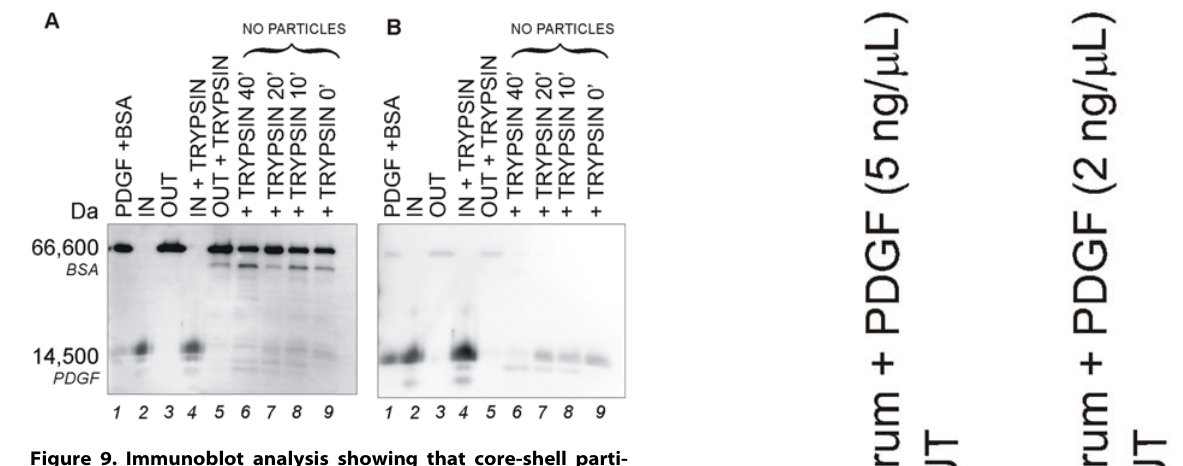
spiked in serum at two different concentrations. As shown above with the ELISA, PDGF in the starting solution was undetectable (Fig. 11, Lane 1 and 4). The particles increased the concentration of PDGF well above the immunoblot detection limit within an extraordinarily complex serum solution, with no detectable alteration in the mass or abundance of the PDGF molecule.